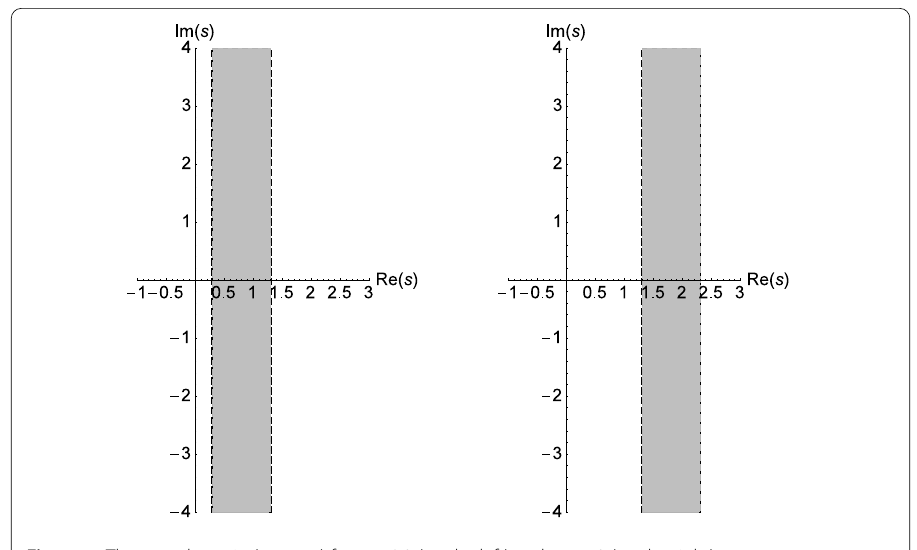
Figure 1 The complex strip ( α ,1 + α ) for α = 0.3 (on the left) and α = 1.3 (on the